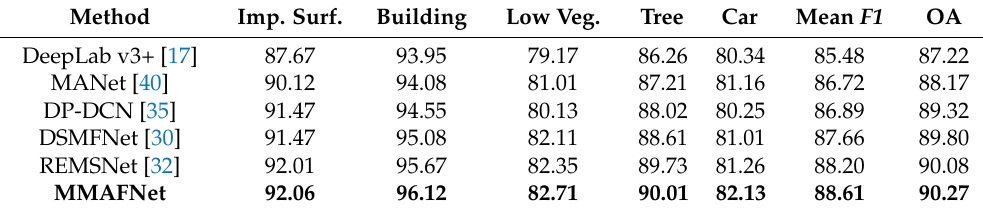
Table 2. Experimental results on the Vaihingen dataset (%). Best results are in bold. Method Imp. Surf.